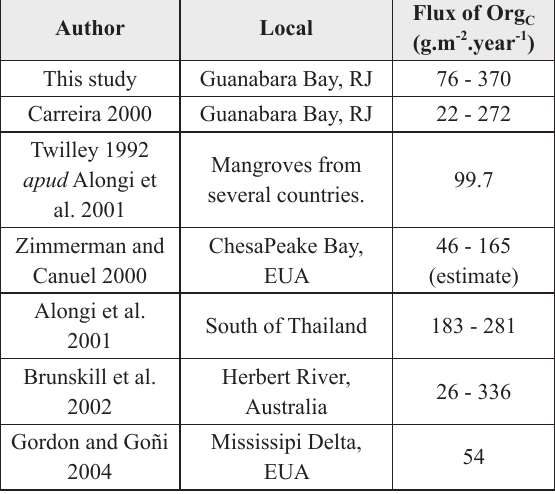
Figure 3 - Profile the Ln excess activity 210 Pb and the rates of sedimentation calculated for the sediment core.